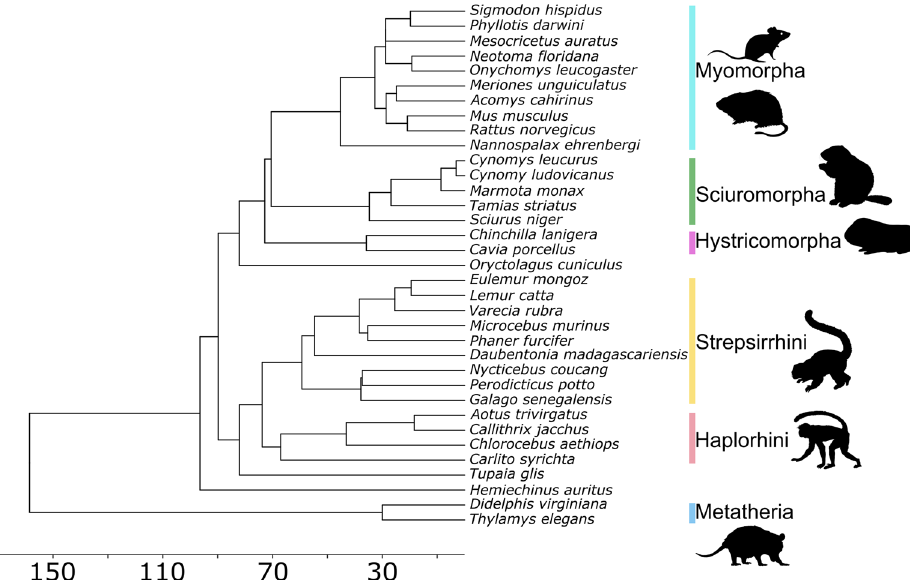
Figure 2. Phylogenetic tree for the species used in our analyses. Topology and divergence times were obtained from TimeTree 66 . The horizontal axis and associated numbers show divergence times in million years before present. Animal silhouettes are available for use under a Public Domain or Creative Commons license, and were obtained from PhyloPic (http:// phylo pic.